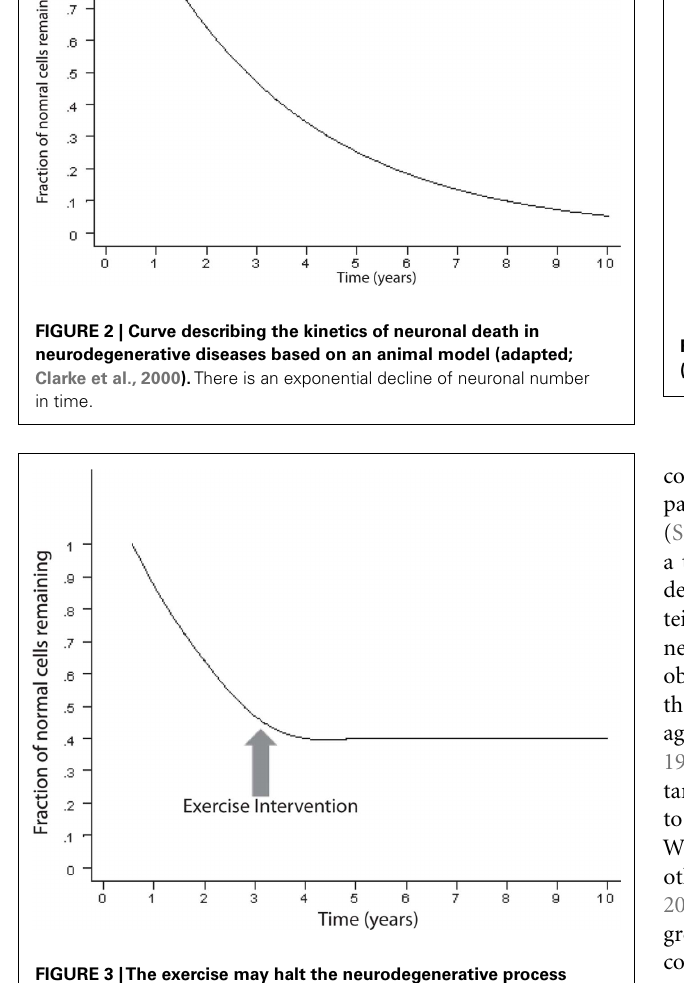
FIGURE 3 |The exercise may halt the neurodegenerative process depending on the time of intervention.